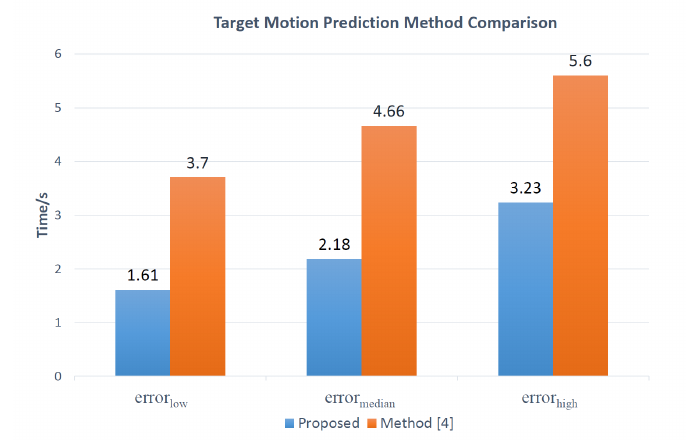
Figure 8. Target motion prediction method